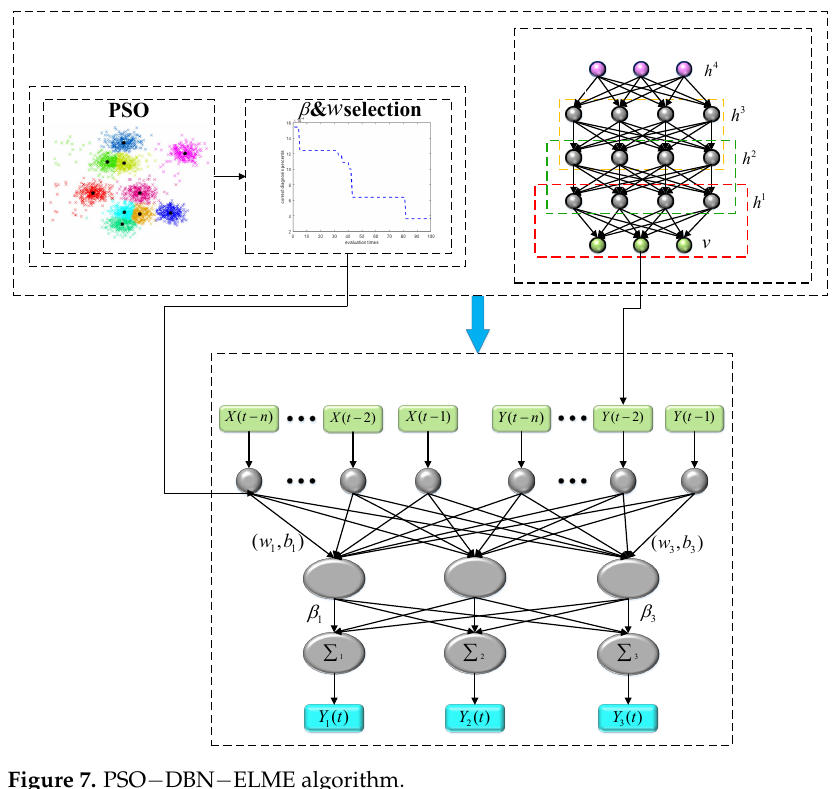
Figure 7. PSO − DBN − ELME algorithm.